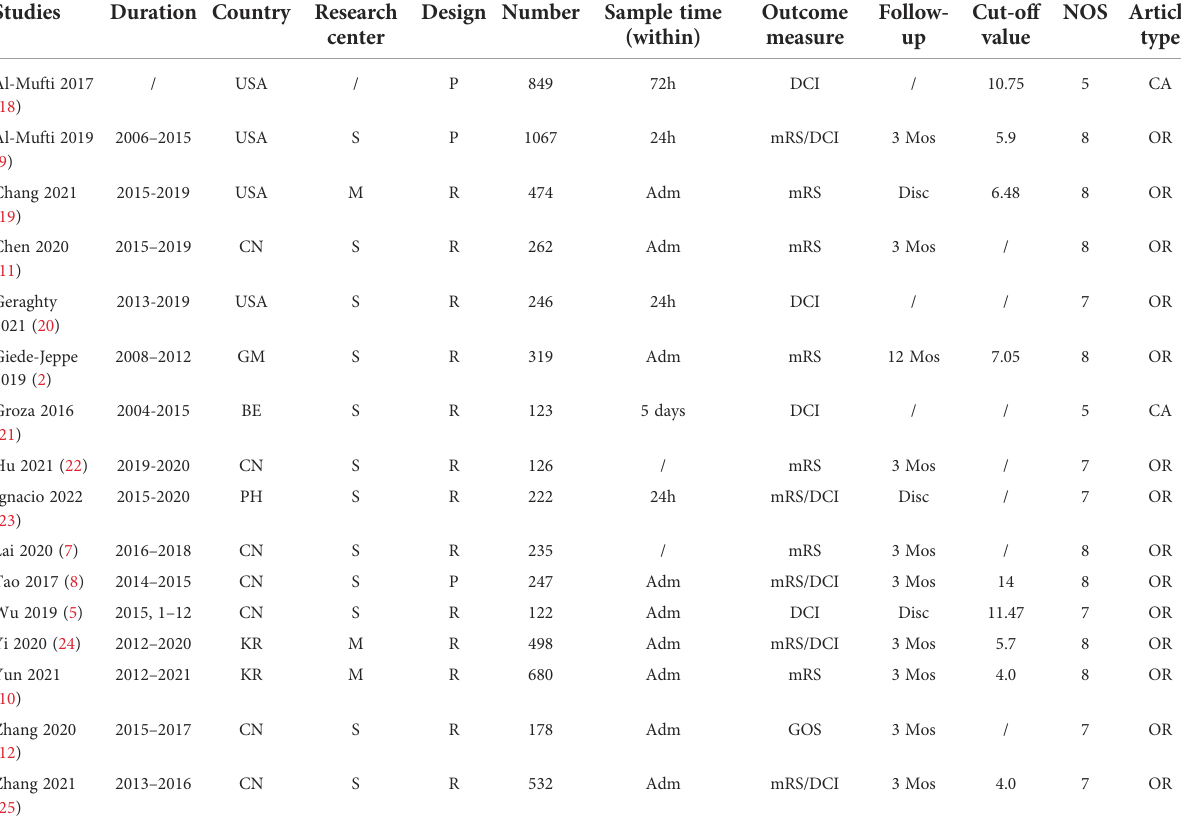
TABLE 3 Baseline characteristic of the enrolled